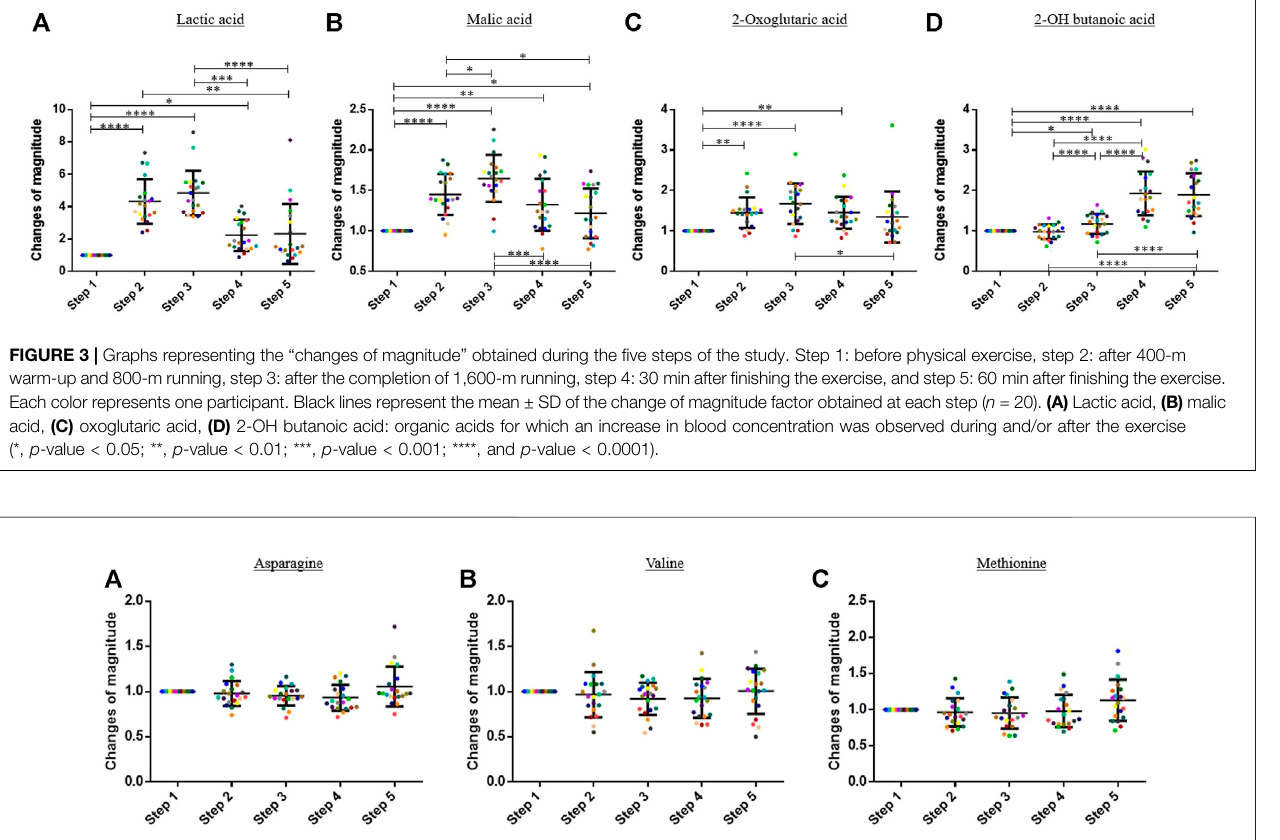
was performed to compare the means of the change of magnitude factors for lactic acid, malic acid, and 2-oxoglutaric acid. For 2-OH butanoic acid, the highest blood concentration was observed 30 min after fi nishing the exercise ( see Figure 3 ). A slight decrease was observed at step 5, but this decrease was not